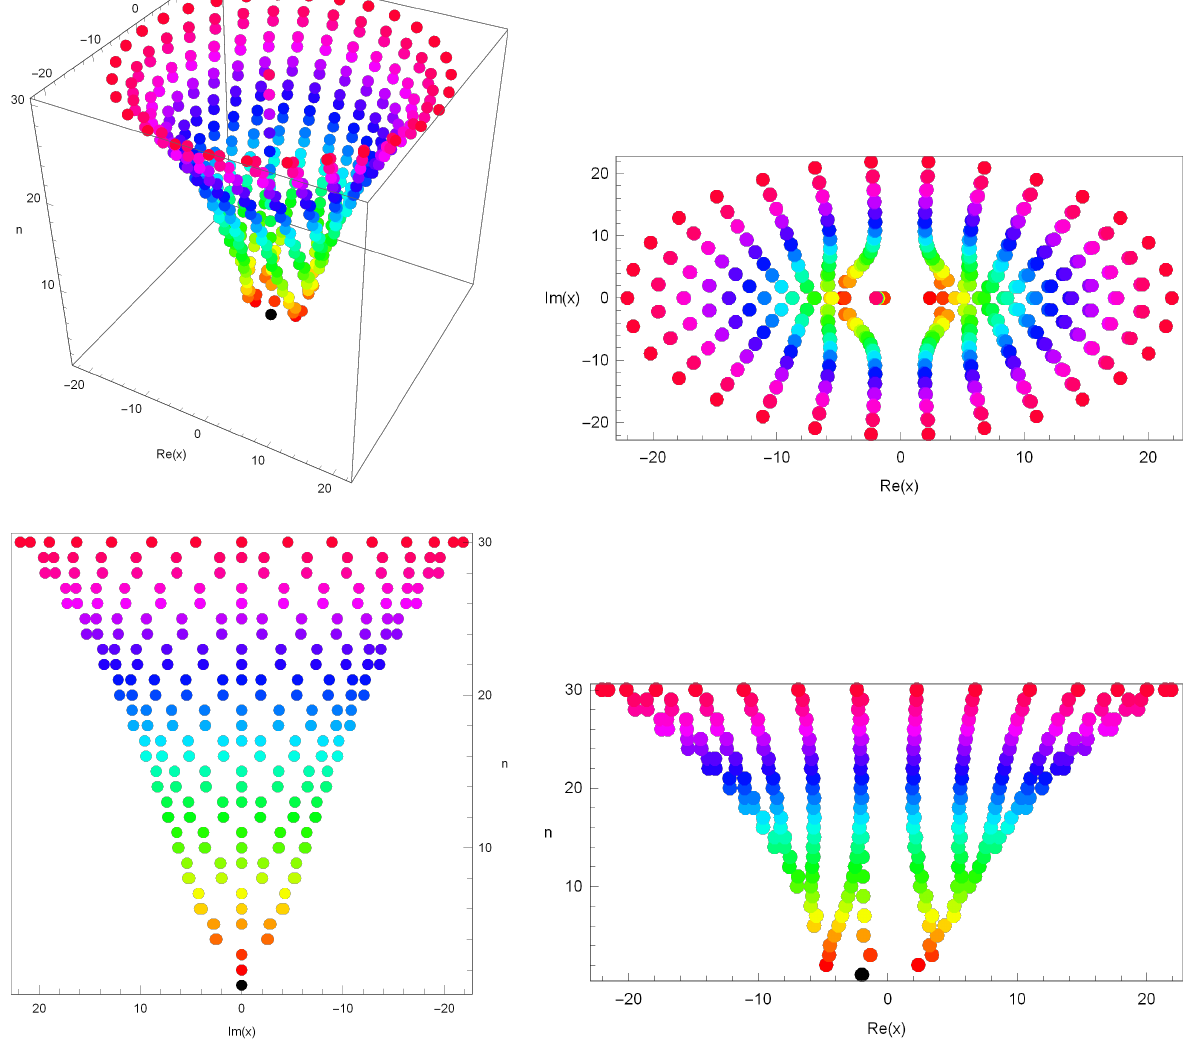
Figure 2. Stacking structure of approximation roots in ( p , q ) -cosine geometric polynomials when 1 ≤ n ≤ 30, p = 1 , q = 1 , y = 3 and z = 2 in 2 10